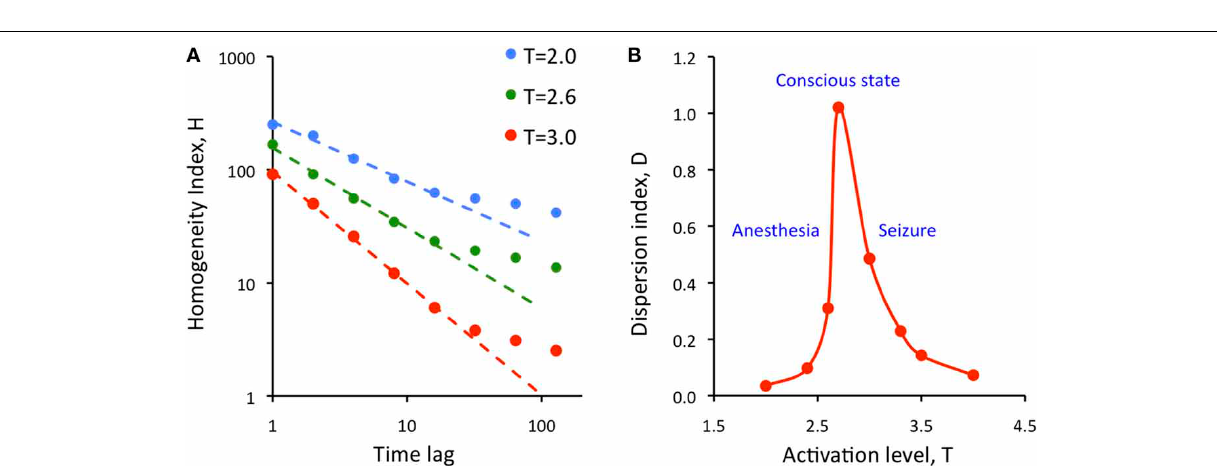
regression slope. (B) Dispersion index, D shows critical behavior as a function of activation level, T. Maximum of D is thought to correspond to the conscious state. D drops at low T (anesthesia) and at high T